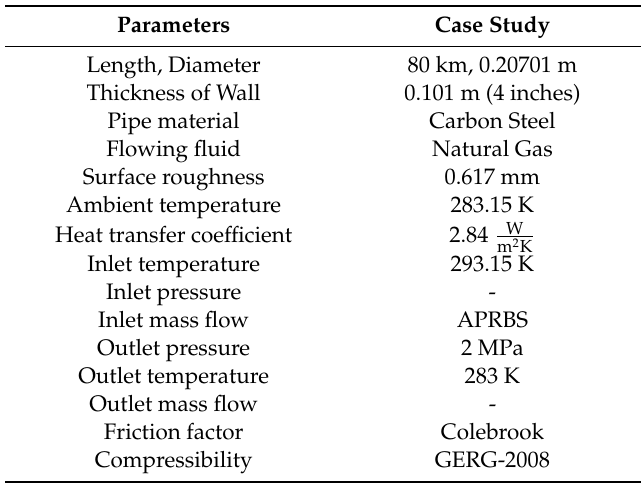
Table 3. Boundary conditions and other parameters used in case study.